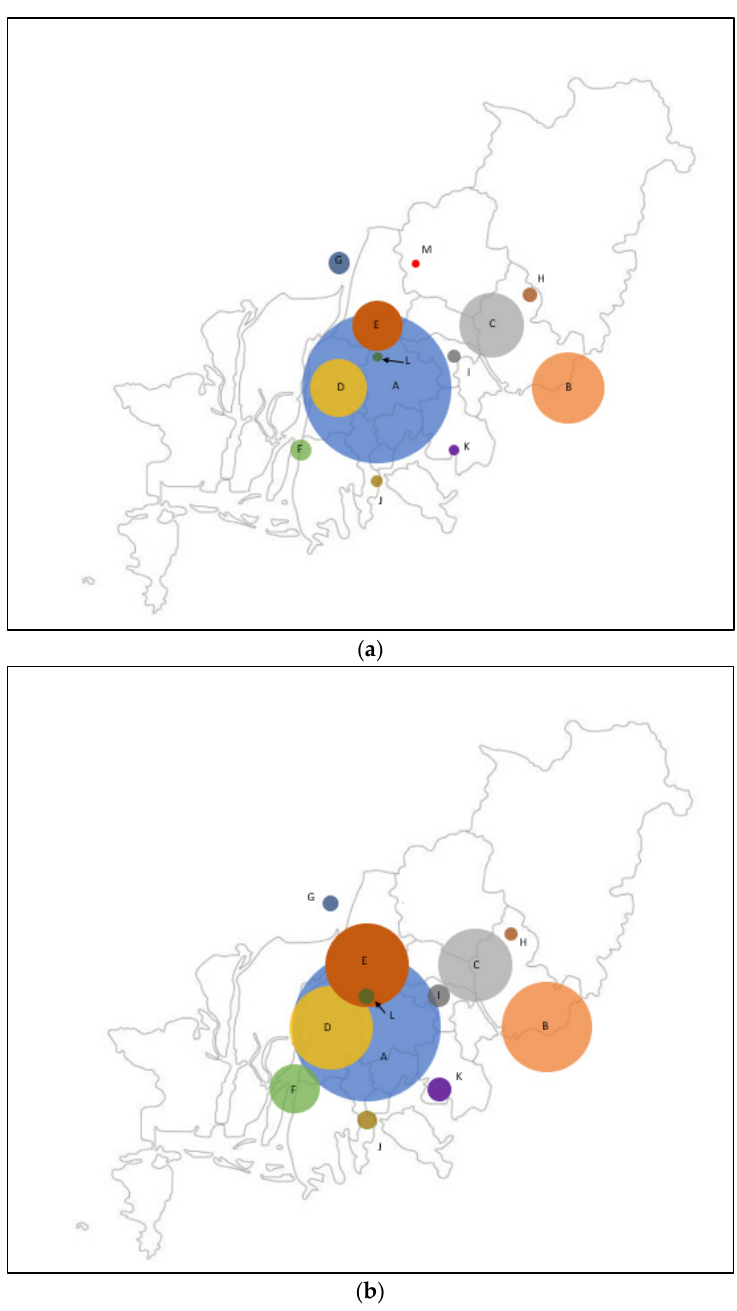
Figure 3. Comparison of the number of patients with acute stroke symptoms using EMS who were transferred to EDs before and amid COVID-19. The diameter of the bubble is proportional to the number of patients transferred to the ED. The color of the bubble for each ED is as follows: A (blue), B (apricot), C (gray), D (mustard), E (brick), F (chartreuse), G (deep blue), H (ochre), I (deep gray), J (camel), K (violet), L (dark green), and M (red). A, C, D, E, F, and G are university hospitals. A has a stroke center. A and G have regional emergency medical centers. M was designated as a hospital dedicated to COVID-19 after the COVID-19 pandemic. ED; emergency department, EMS; emergency medical service, COVID-19; coronavirus disease-19. ( a ) Bubble figure of the number of patients with acute stroke symptoms using EMS who were transferred to EDs before COVID-19. ( b ) Bubble figure of the number of patients with acute stroke symptoms using EMS who were transferred to EDs during COVID-19.